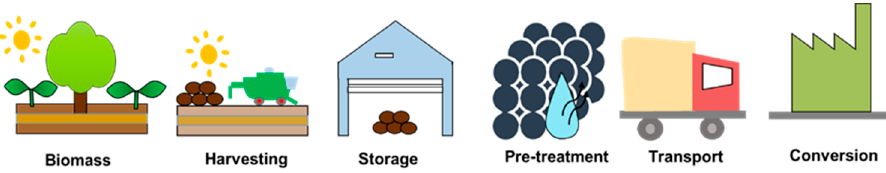
Figure 2. General steps of biomass supply chain.